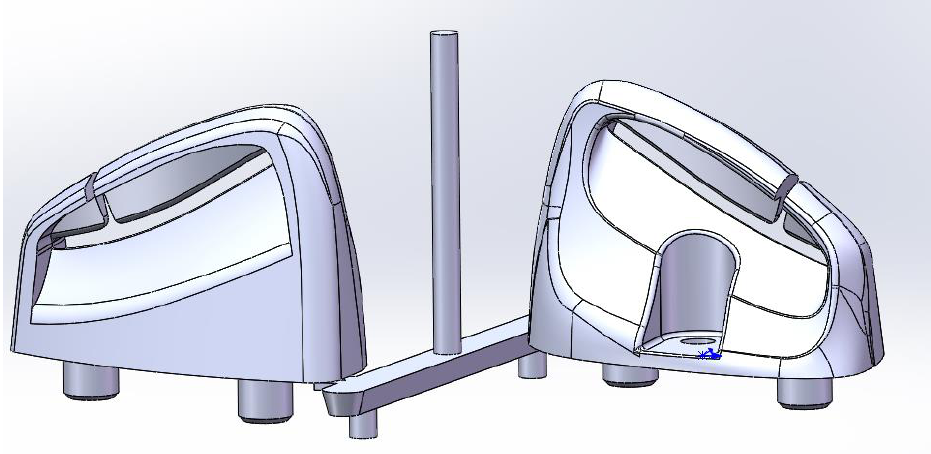
Figure 3. Auto interior part—seat belt guider sample diagram by Creo 2.0.